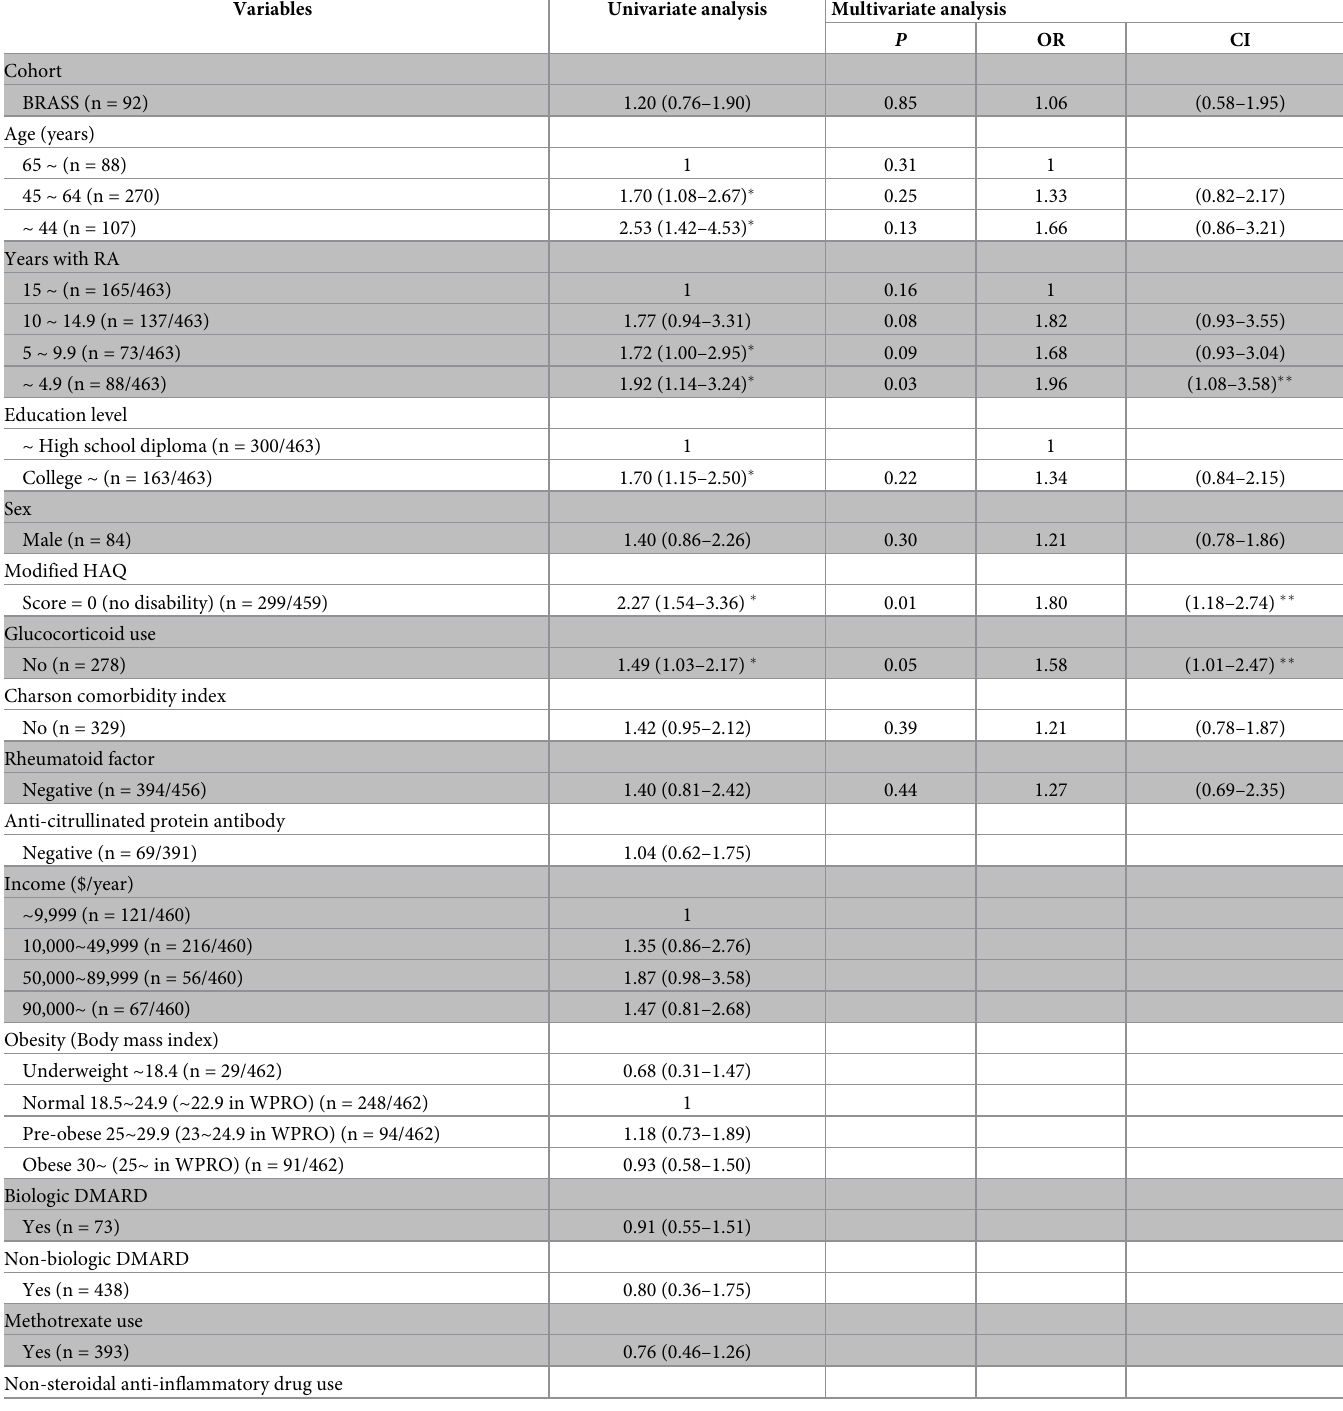
Table 3. Predictors for sustained remission in rheumatoid arthritis patients (n =